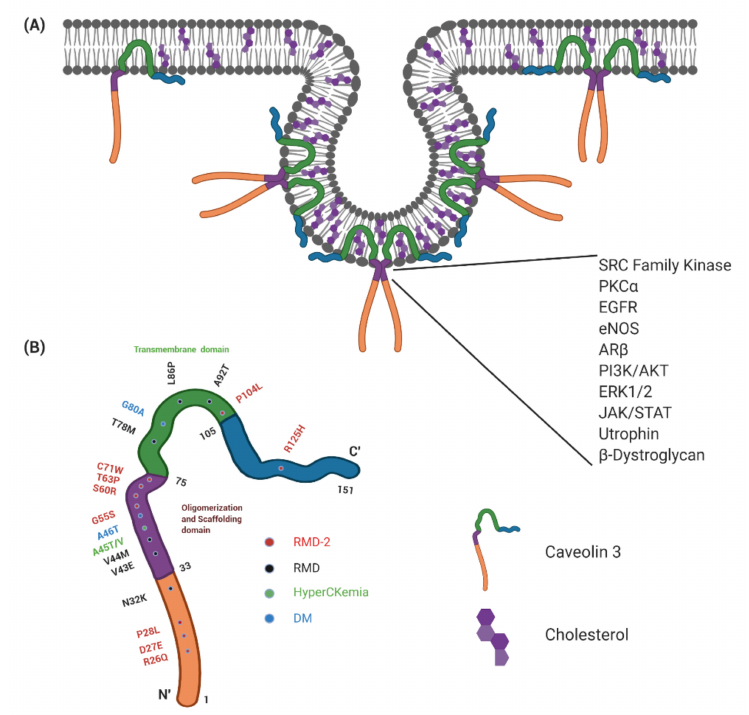
Figure 1. Caveolin-3 domain organization and its localization to caveolae. ( A ) A diagrammatic representation of caveolae with associated Caveolin-3 protein. Caveolae are rich in cholesterol and provide platforms for various signaling molecules like GPCRs, Src kinase, etc. that interact with Caveolins’ sca ff old domain (shown on the right). The plasma membrane also contains Caveolin-3, which is not associated with caveolae. ( B ) Mutations in Caveolin-3 causing caveolinopathies. The figure was created with